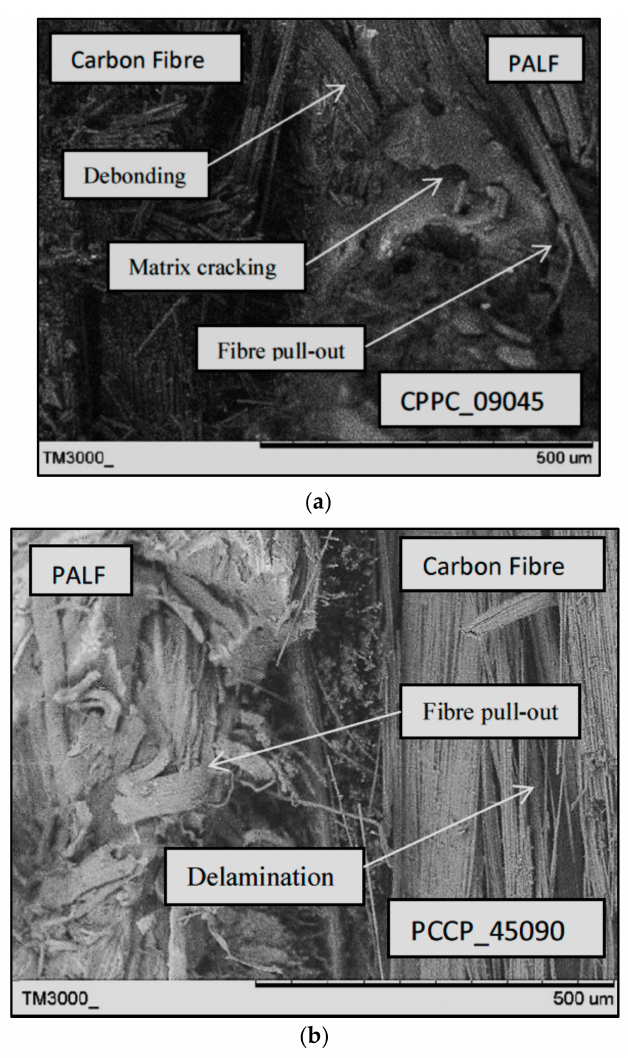
Figure 10. SEM images of; ( a ) CPPC_09045 and ( b ) PCCP_45090 at a 45% UTS